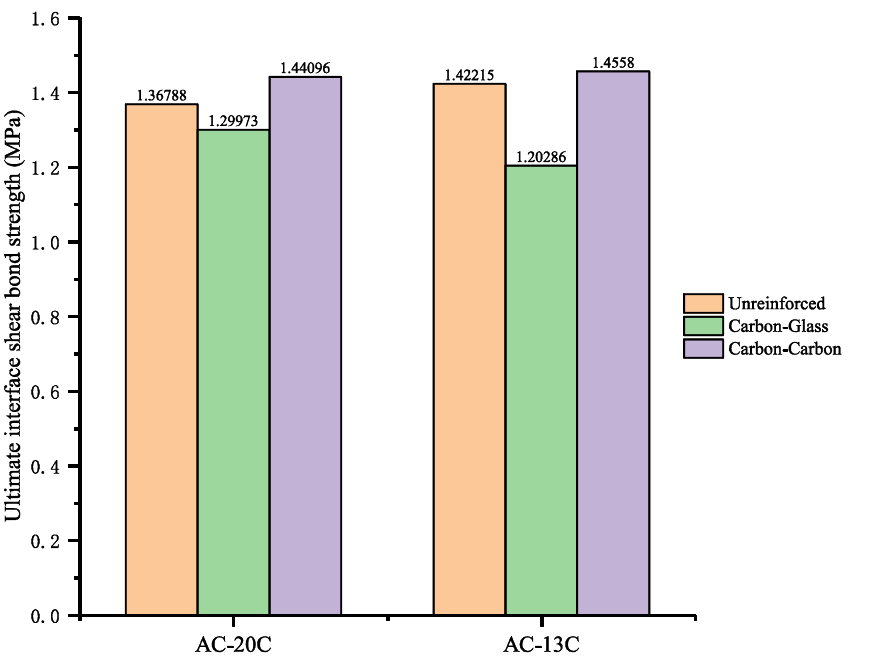
Figure 7. The results of the oblique shear tests.